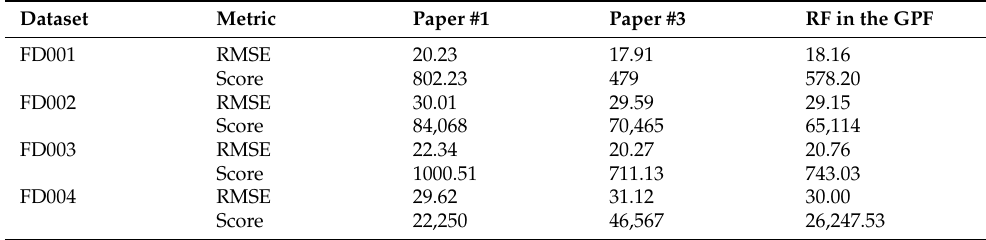
Table 7. Random Forest algorithm RMSE and score on the three papers of literature and using the